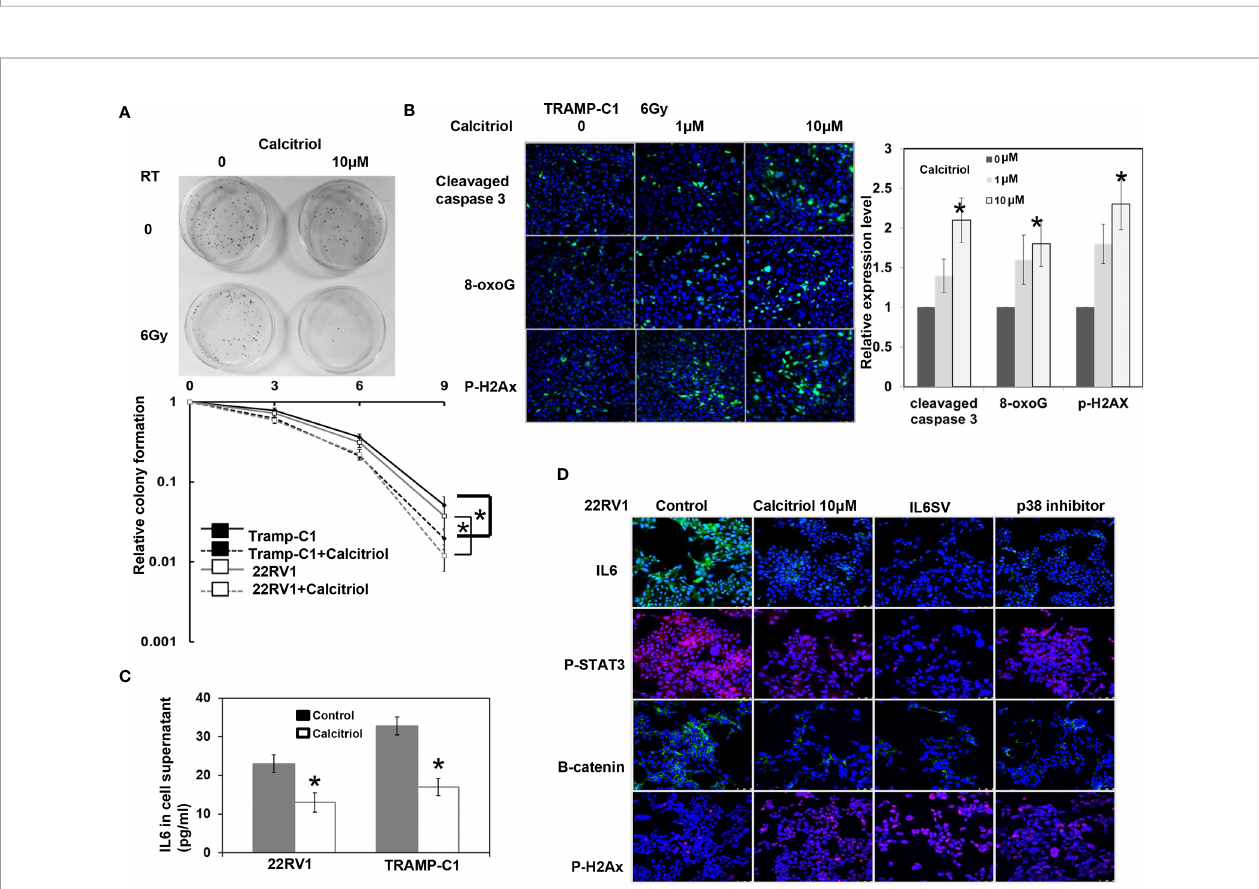
FIGURE 4 | Effects of Calcitriol on radiation responses in vitro. (A) Calcitriol signi fi cantly increased RT-induced cell death by clonogenic assay. The survival fraction was determined by enumerating colonies after irradiation exposure divided by the colony numbers with the respective condition and sham irradiation. Points, means of 3 separate experiments; bars, SD. *P < 0.05. (B) Effect of Calcitriol treatment on apoptosis-related protein and DNA damage was demonstrated by immuno fl uorescence in vitro (DAPI, blue; target protein, green). The quanti fi cation is to calculate the value of the cell number positive for targeted protein divided by the total cell number. The Y-axis represents the ratio normalized by the value of irradiated cells under control condition. *p < 0.05. (C) The levels of IL-6 in cellular supernatants were examined by ELISA in vitro . Columns represent the means ± SD. *P < 0.05. (D) The expression levels of IL-6/p-STAT3, B-catenin and Ki-67 were evaluated by immuno fl uorescence using 22RV1 cells incubated in the presence of indicated dosage of calcitriol or p38 inhibitor for 48 h and the results of representative slides are